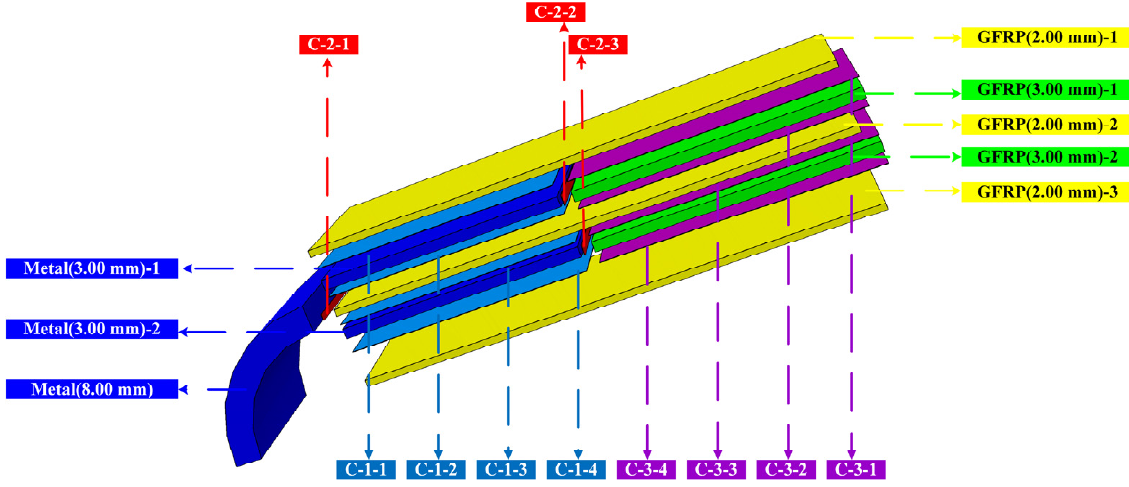
Figure 10. Schematic diagram of disassembly of metal-composite L-joint structure.